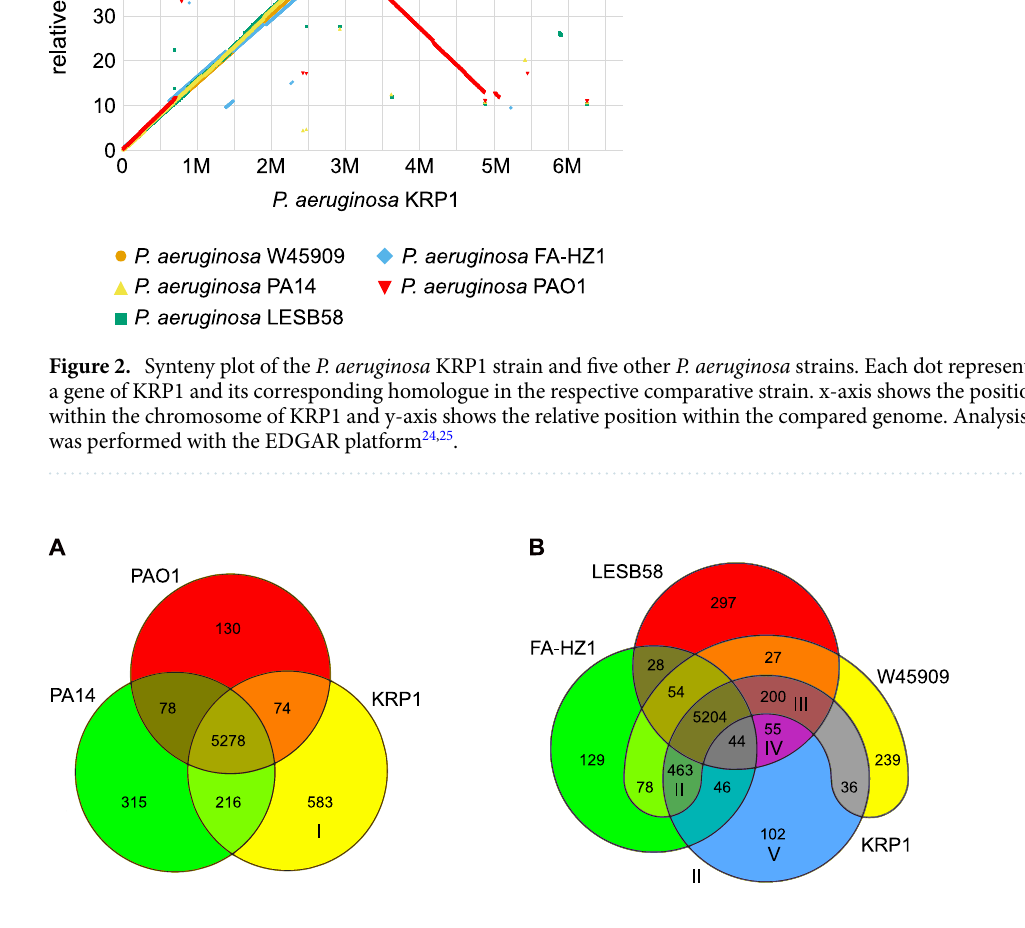
Figure 3. Venn diagrams showing the number of genes shared as orthologues in all possible logical combinations between different strains of P. aeruginosa . A: PAO1 [red], PA14 [green], KRP1 [yellow]; B: LESB58 [red], FA-HZ1 [green], KRP1 [blue], W45909 [yellow]. For further information regarding individual areas marked with roman numbers see text. Analysis was performed with the EDGAR platform 24,25